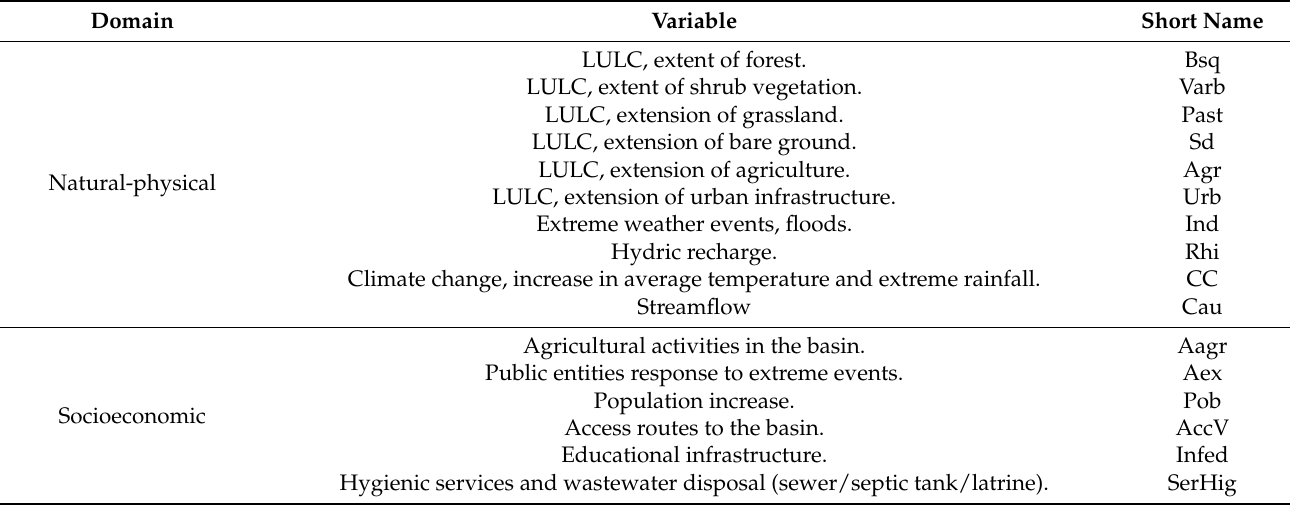
Table 1. Domains and input